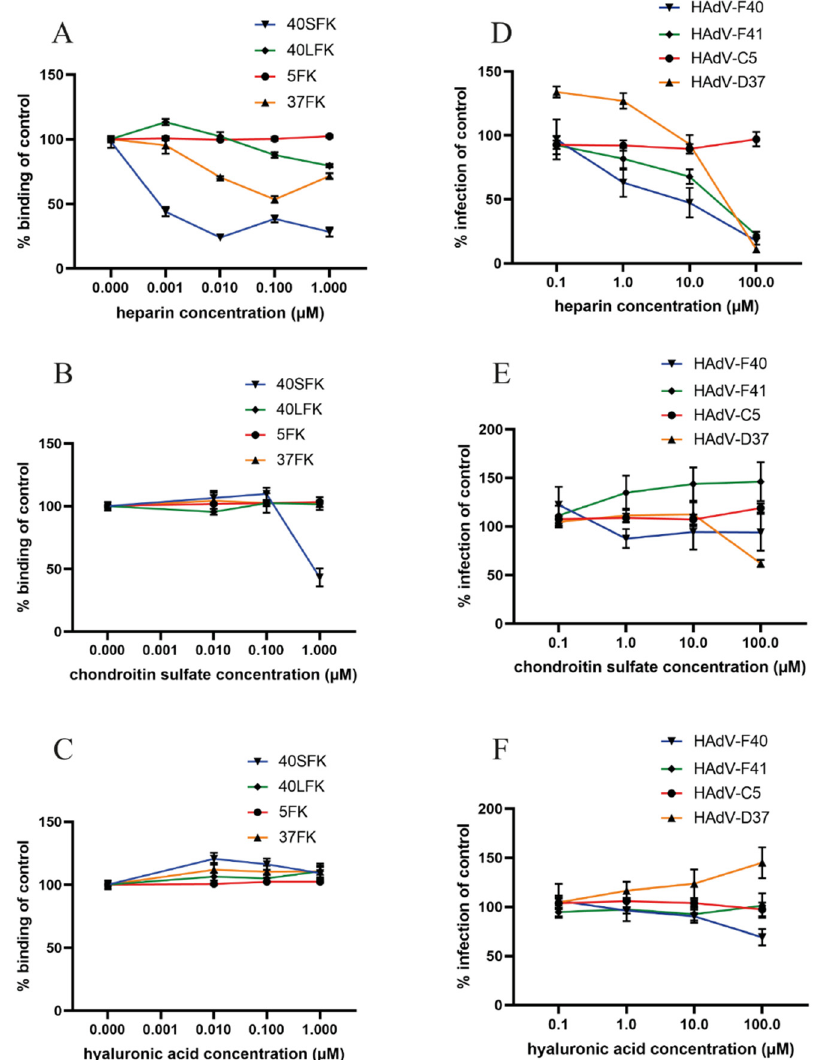
Figure 7. Effect of GAGs on fiber knob binding to and infection of HuTu80 cells: Binding of ( A ) heparin or ( B ) chondroitin sulfate mix or ( C ) hyaluronic acid pretreated HAdVs on HuTu80 cells. Binding was determined by geometric mean of fluorescence on a FACSLSRII flow cytometer and shown as % binding of untreated fiber knobs. Infection of ( D ) heparin or ( E ) chondroitin sulfate mix or ( F ) hyaluronic acid pretreated virions to HuTu80 cells. The number of infected cells were quantified by immunofluorescence and shown as % infection of untreated HAdVs. All experiments were performed three times with duplicate samples in each experiment.